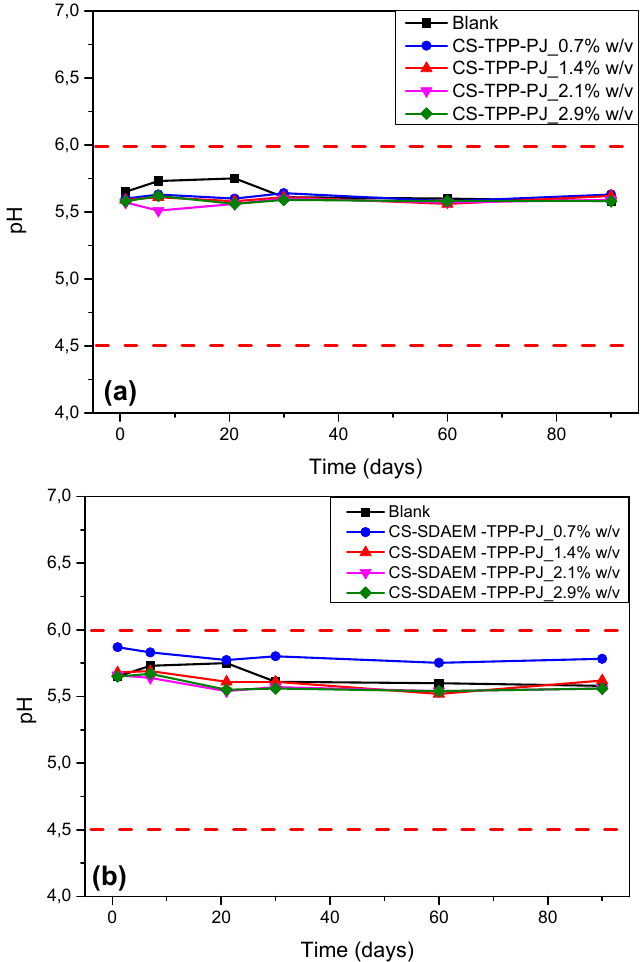
Figure 10. pH values of the prepared emulsions during storage stability studies of the samples ( a ) CS-TPP-PJ_0.7, 1.4, 2.1 and 2.9% w / v and ( b ) CS-SDAEM-TPP-PJ_0.7, 1.4, 2.1 and 2.9% w / v . The red dotted lines depict the pH of the healthy human skin.